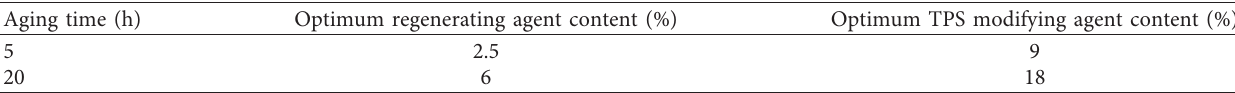
Figure 5: Index curve of modified regenerating asphalt in different modifying agent contents. Table 8: Optimum modifying agent content in different aging time.